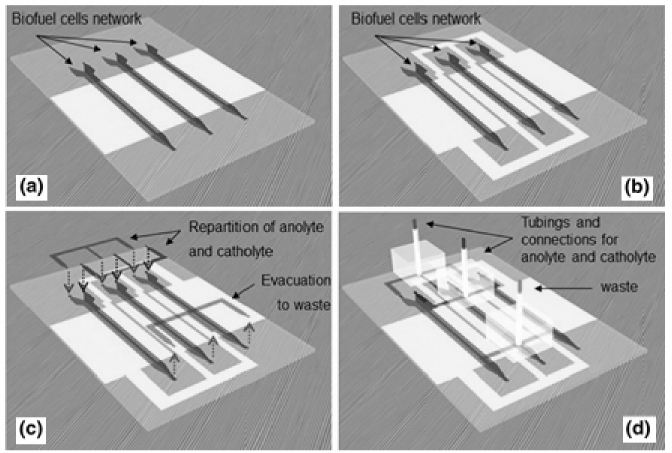
Figure 8. Multilayer microfluidic biofuel cell fabrication based on xurography technique used in [41]; ( a ) serial configuration of electrodes; ( b ) parallel configuration of electrodes; ( c ) schematic view of repartition layer; ( d ) final structure of the enzymatic microfluidic